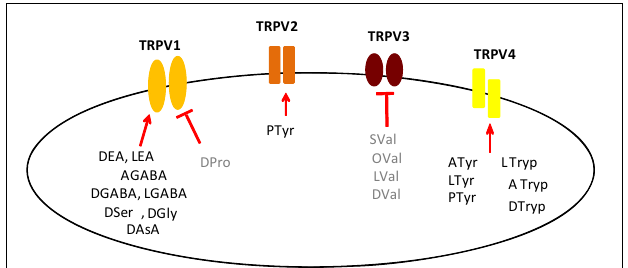
FIGURE 3 | Composite for all individual N -acyl amides tested here with activity at TRPV1-4. This cartoon illustrates N-acyl amides that were shown to be active as agonists (Bold Black; arrow) and antagonists (Bold Gray; bar) in each of the TRPV1-4 expression systems, which are represented simply as the individual receptor. Agonists at TRPV1: N -docosahexaenoyl GABA (DGABA), N -arachidonoyl GABA (AGABA), N -linoleoyl GABA (LGABA); N -docosahexaenoyl serine (DSer), N -docosahexaenoyl glycine (DGly), N -docosahexaenoyl aspartic acid (DAsA), N -docosahexaenoyl ethanolamide (DEA), N -linoleoyl ethanolamide (LEA); Antagonists at TRPV1: N - docosahexaenoyl proline (DPro); Agonists at TRPV2: N-palmitoyl tyrosine (PTyr); Antagonists at TRPV3: N -docosahexaenoyl valine (DVal), N -linoleoyl valine (LVal), N -oleoyl valine (Oval), N -stearoyl valine (SVal); Agonists at TRPV4: N -arachidonoyl tyrosine (ATyr), N -linoleoyl tyrosine (LTyr); PTyr; N -docosahexaenoyl tryptophan (DTryp), N -arachidonoyl tryptophan (ATryp), N -linoleoyl tryptophan